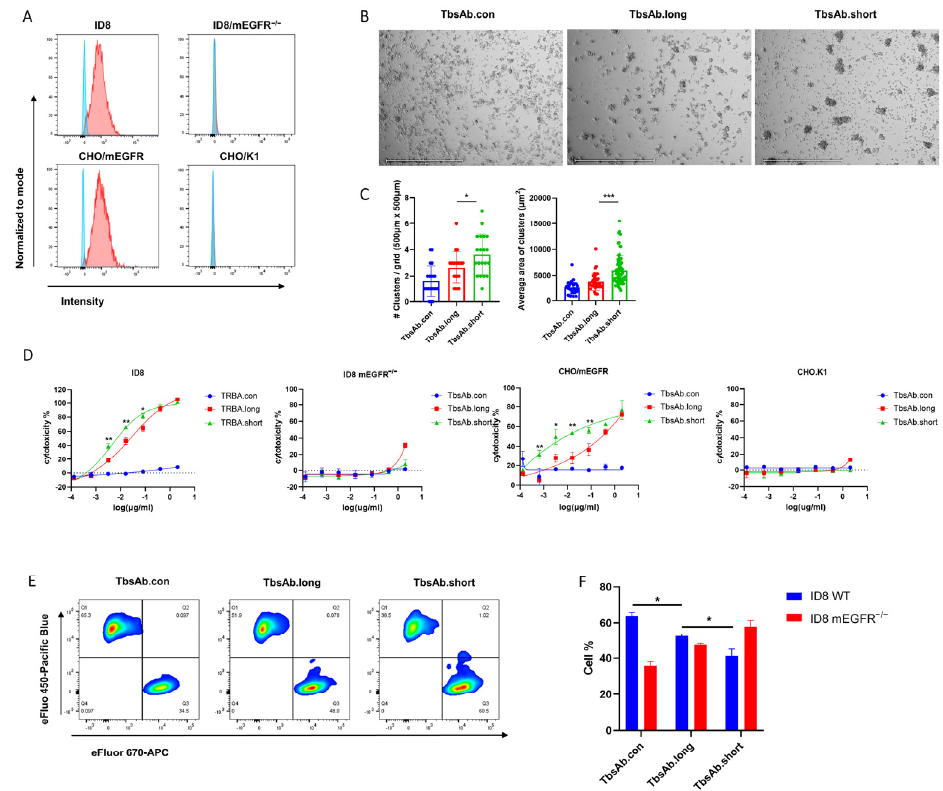
Figure 4. The TbsAb.short form mediates superior T cell mediated cytotoxic. ( A ) Expression of mEGFR on ID8, ID8/mEGFR − / − , CHO/mEGFR and CHO/K1 cell lines were measured by flow cy- tometry. ( B ) OT-1 T cell blasts with CHO/mEGFR cells in the presence of 0.02688 nM (0.0032 µg/mL) of either mCD3E x mEGFR TbsAb.long or TbsAb.short at an E: T ratio of 5:1 following 24 h incubation. Images were obtained under 4 × magnification, and scale bars 650 µm. ( C ) Quantified number of T cell blasts per grid and average area per T cell blasts by EVOS analysis software. ( D ) In vitro cytotoxicity assay of mCD3E × mEGFR TbsAbs using LDH release assay. Curves were fitted using a four-parameter logistic fitting with GraphPad Prism 8. ( E ) In vitro cytotoxicity assay of mCD3E × mEGFR TbsAbs (0.02688 nM, equal to 0.0032 µg/mL) using FACS. ( F ). Data points represent the mean of three samples; error bars, SD. *: p < 0.05; **: p < 0.01; ***: p < 0.001.